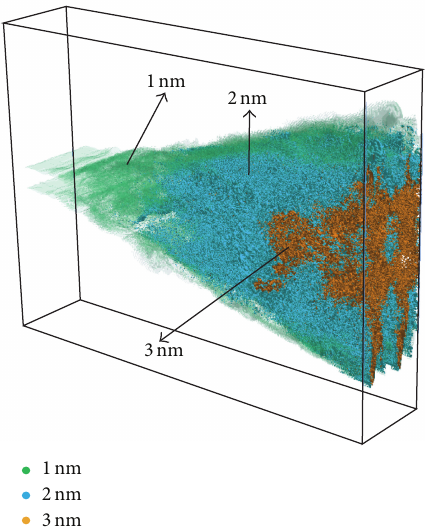
Figure 4: Instantaneous isosurfaces of 1nm, 2 nm, and 3 nm particles at 𝑡 ⋆ = 100 .